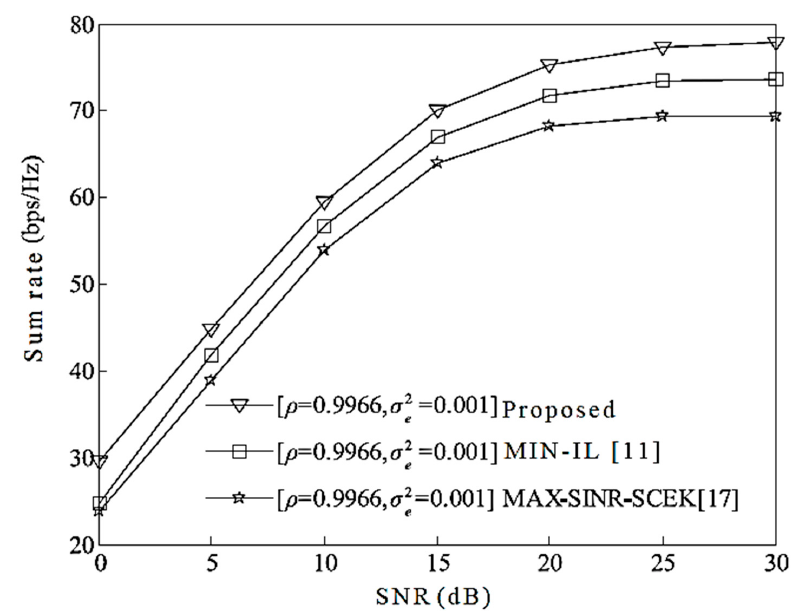
Figure 3. Average system capacity comparison under time delay error CSI.